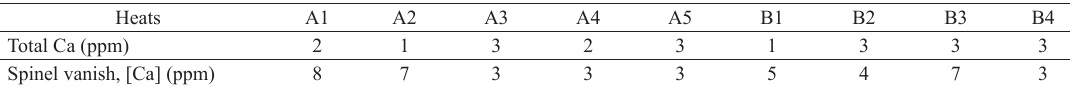
Table 3. Total Calcium content in steel and [Ca] calculated for the disappearance of spinel inclusions. Sample